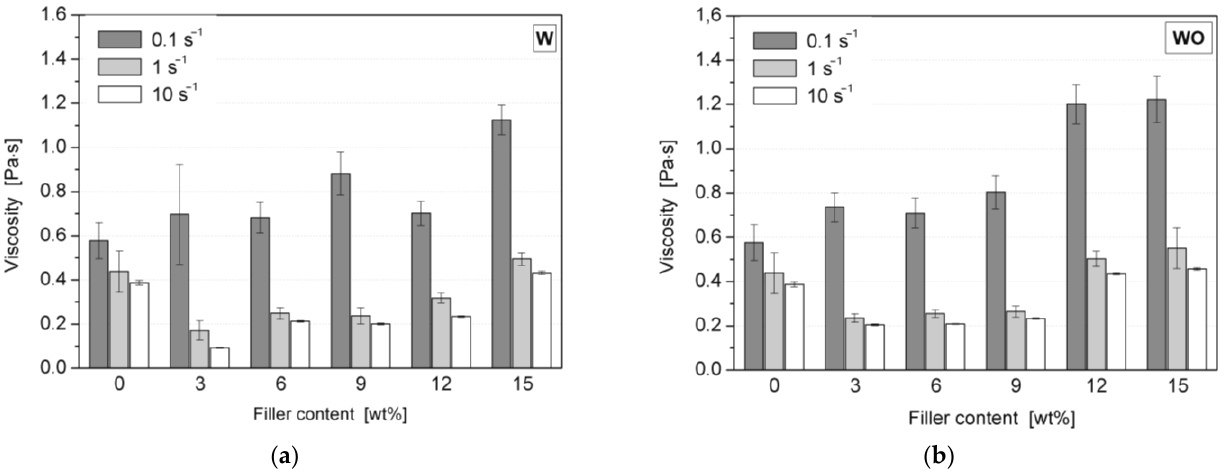
Figure 4. Rheological properties of polyol-W ( a ) and -WO ( b ) premixes with various filler contents measured with 0.1, 1, and 10 s −1 shear rates.